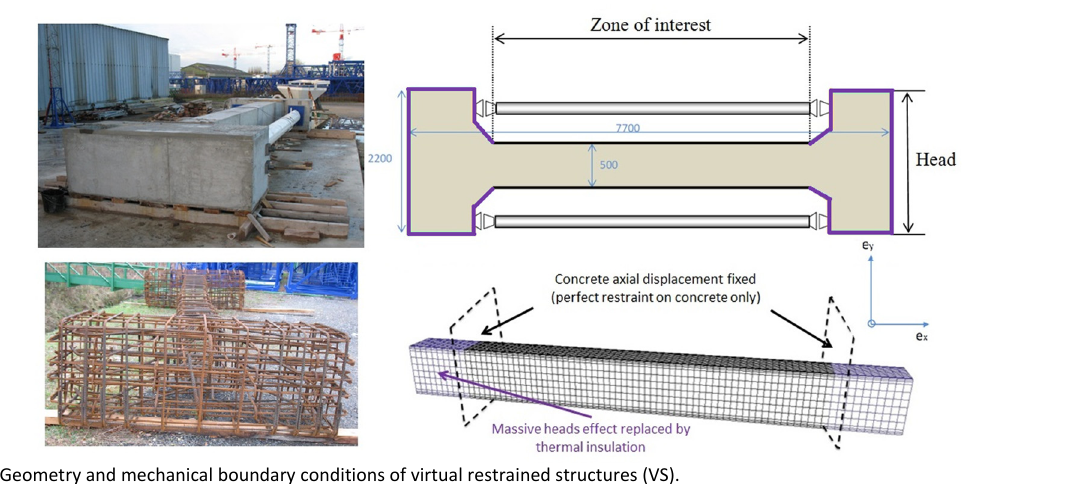
Figure 12. Geometry and mechanical boundary conditions of virtual restrained structures (VS).